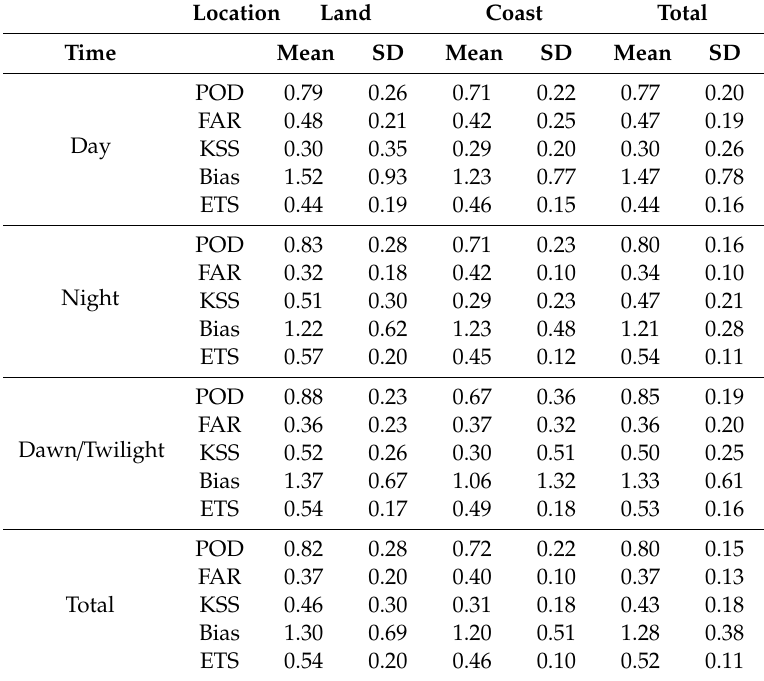
Table 5. Summary of the validation results for the training cases according to time and geographic